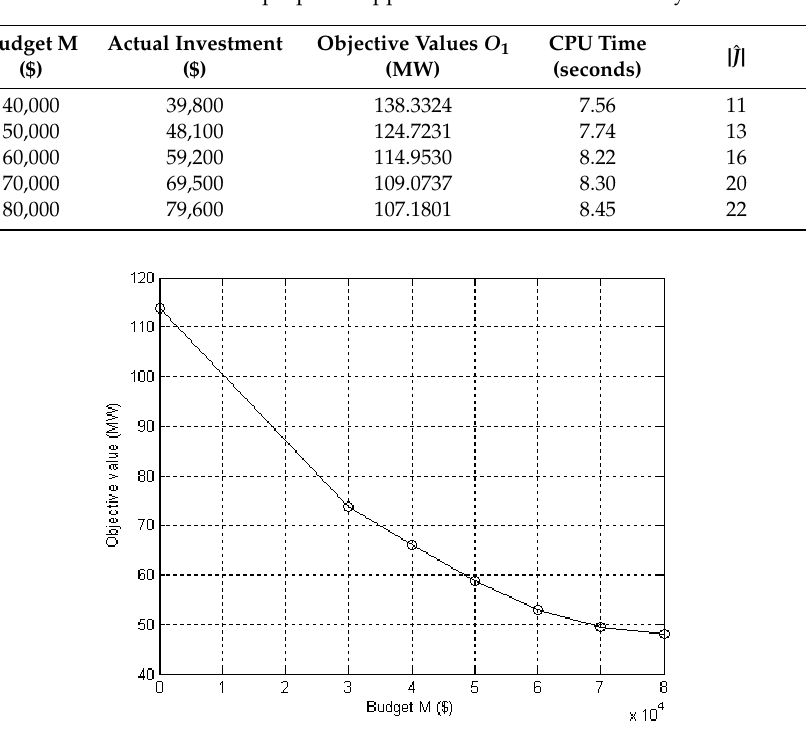
Table 2. Results of the proposed approach on the IEEE 244-bus system.